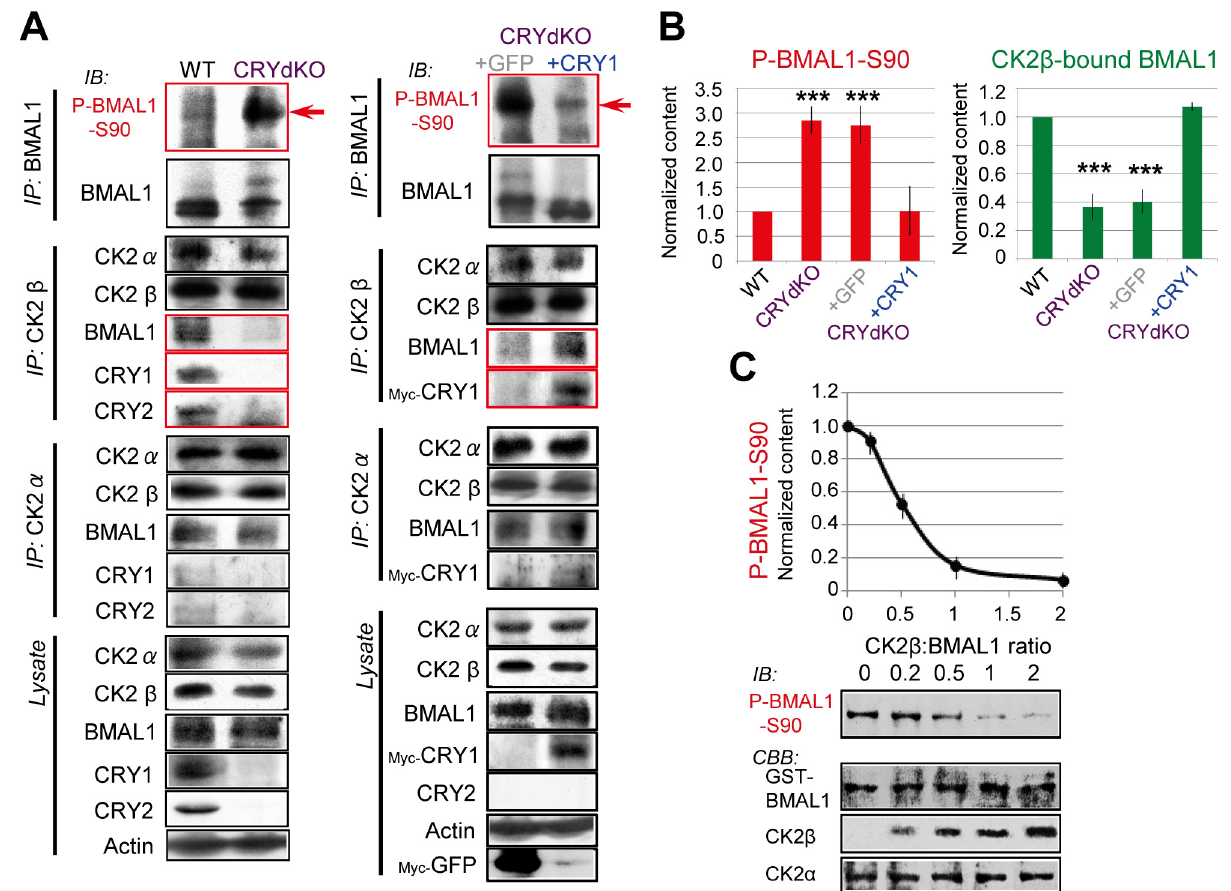
Fig 2. CRY regulates CK2-mediated BMAL1-Ser90 phosphorylation. (A) Co-immunoprecipitation experiments with non-clock synchronized wild type (WT) and CRYdKO ( Cry1 -/- /Cry2 -/- ) mouse embryonic fibroblasts (MEFs), and CRYdKO MEFs stably expressing mCry1 promoter-driven Myc-CRY1 or CMV- promoter-driven Myc-GFP (control). IB analysis of BMAL1-, CK2 α -, and CK2 β -IP and lysates for BMAL1, P-BMAL1-S90, CK2 α , CK2 β , CRY1, CRY2, and actin (control). Shown are representative examples of n = 3 experiments. Red arrows indicate the position of major P-BMAL1-S90 (~90 kDa). (B) Quantification of P-BMAL1-S90 and CK2 β – BMAL1 levels. Values in WT MEFs are set as 1. Error bars indicate SD. (C) In vitro analysis of CK2 α -mediated BMAL1-S90 phosphorylation. Mixtures of CK2 α and CK2 β subunits and GST-BMAL1 were subjected to an in vitro kinase assay. BMAL1-Ser90 kinase activity was measured by IB analysis with anti-P-BMAL1-S90 (representative examples of n = 3 experiments), and plotted against CK2 β / (GST-) BMAL1 ratio. Values were normalized against activity in the absence of CK2 β , which was set as 1. Error bars indicate SD. Note the inhibition of CK2 α -mediated BMAL1-S90 phosphorylation by CK2 β